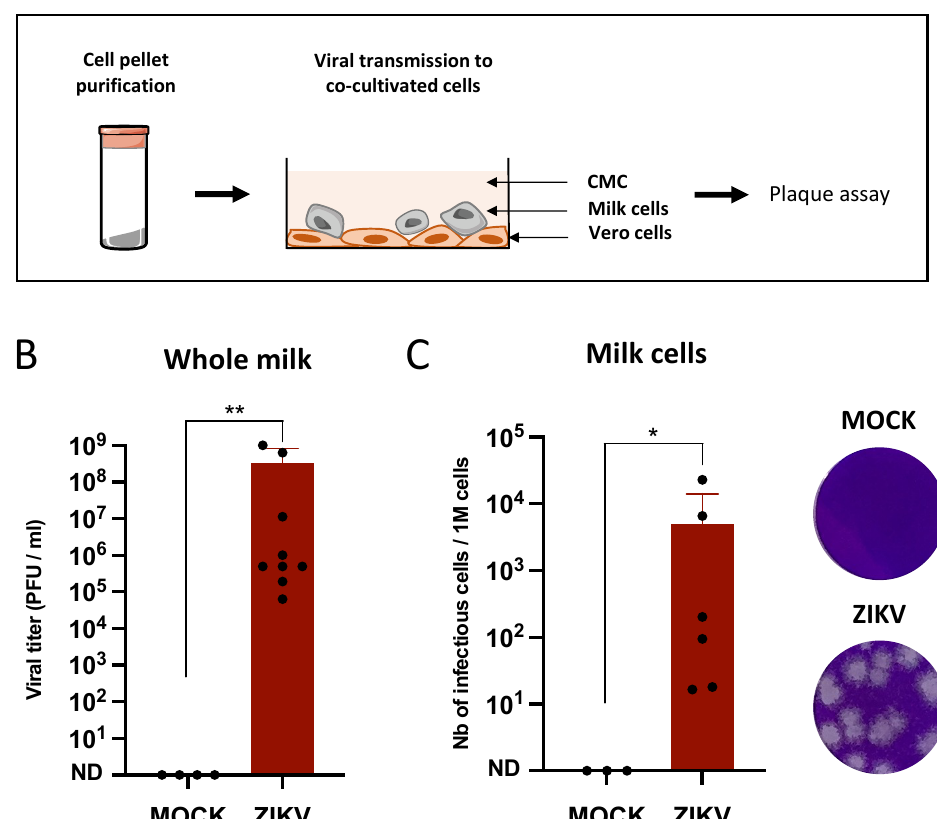
Figure 4. Infectious cell-associated ZIKV is excreted in murine breast milk. ( A ): Female dams were MOCK or ZIKV-infected with the Brazil/2016 strain as described in Figure 1. Breast milk samples were collected at 4 days post-infection and cell pellets were purified by three spin-wash cycles in PBS Figure 4 : Infectious cell-associated ZIKV is excreted in murine breast milk. to eliminate free viral particles. ( B ): The viral titers in the same breast milk samples were determined by plaque assay on Vero cells. ( C ): For each sample ( n = 6), duplicates of one million cells were serially diluted and co-cultured with Vero cells for 2 h at 37 ◦ C. The cells were then co-cultured in medium containing carboxymethylcellulose for 6 days at 37 ◦ C. After three PBS washes and PFA 4% fixation, the cell layers were stained with crystal violet and plaques were counted manually. * and **: Significantly different ( B : p = 0.0015; C : p = 0.023) by Mann–Whitney test ( p <